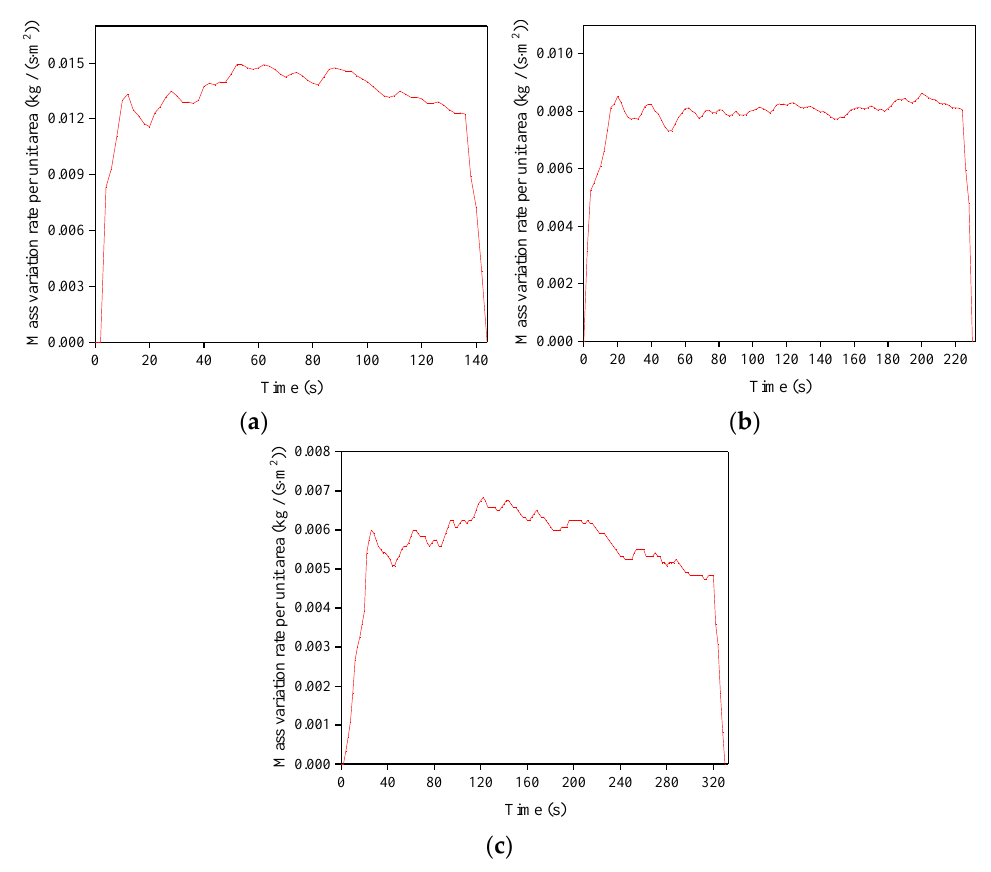
Figure 5. Mass variation rate per unit area of gasoline during the burning process after Karman filtering. ( a ) Chengdu, Sichuan; ( b ) Kunming, Yunnan; ( c ) Lhasa, Tibet.